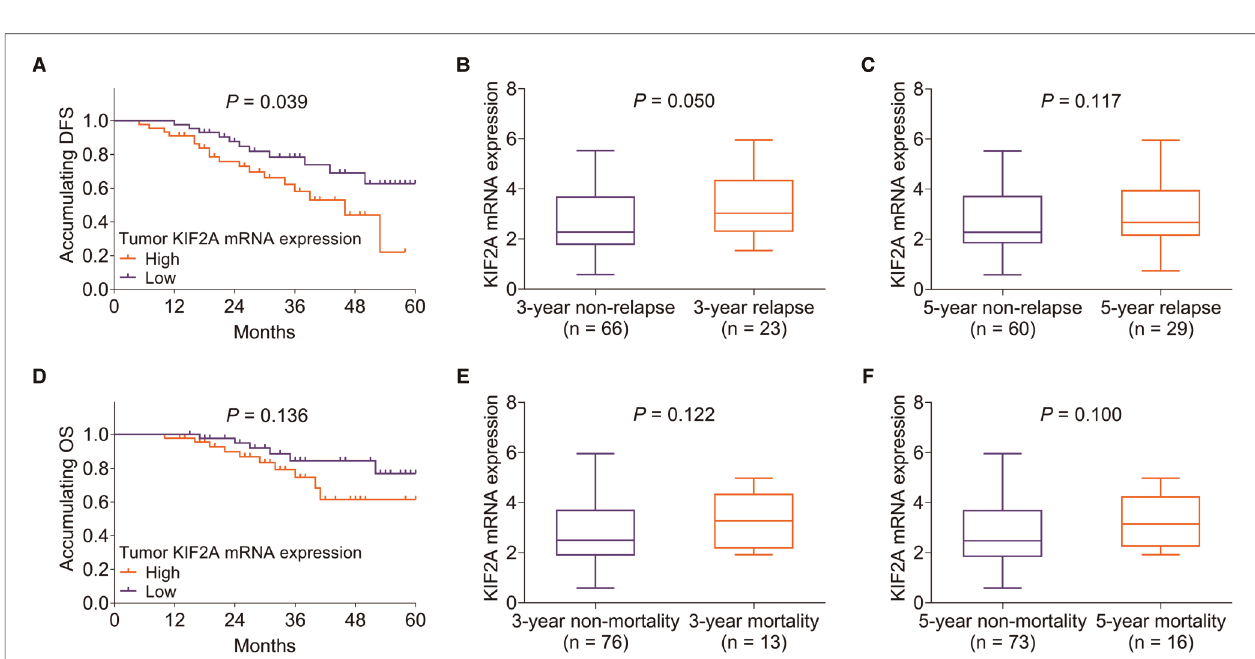
FIGURE 3 | Association of tumor KIF2A mRNA expression with DFS and OS. The association of tumor KIF2A mRNA expression with accumulating DFS in BLBC patients ( A ); the difference of tumor KIF2A mRNA expression between relapsed BLBC patients and non-relapsed patients within 3 years ( B ) and 5 years ( C ). The association of tumor KIF2A mRNA expression with accumulating OS in BLBC patients ( D ); the difference of tumor KIF2A mRNA expression between BLBC deaths and survivors within 3 years ( E ) and 5 years ( F ). KIF2A, kinesin family member 2A; BLBC, basal-like breast cancer; DFS, disease-free survival; OS, overall